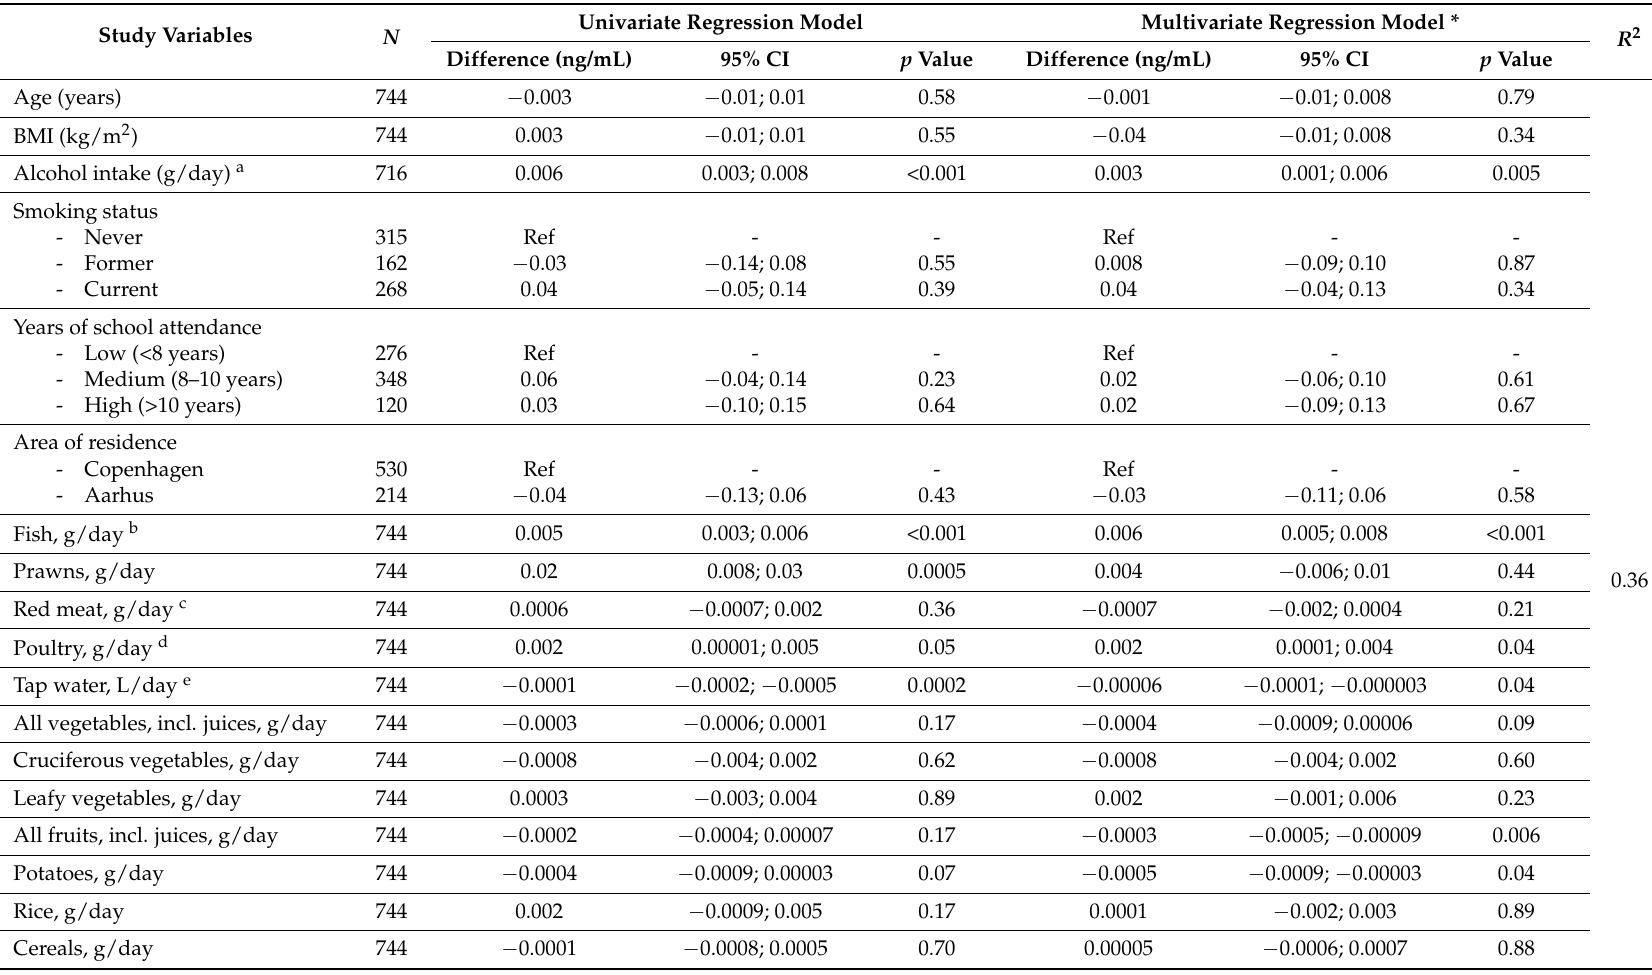
Table 3. Association between log 10 -transformed urinary arsenic levels and baseline study characteristics. Results of univariate and multivariate regression models. Study